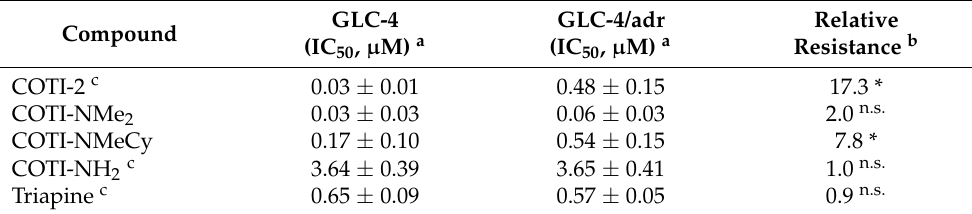
Table 5. Anticancer activity (IC 50 values after 72 h) of the indicated TSCs in GLC-4, as well as its ABCC1-overexpressing subclone GLC-4/adr.